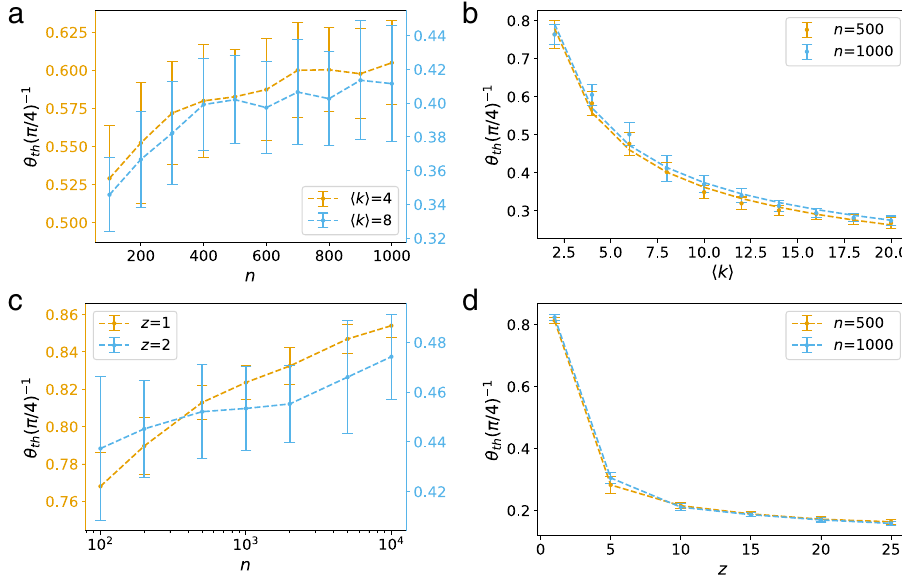
Fig. 10 The Fast ConPT calculation on complex networks. a The behavior of θ th for ER networks with k h i ¼ 4 and k h i ¼ 8 under the S 1 approximation with increasing network size. b The behavior of θ th for Erd ő s--Rényi (ER) networks with n = 500 and n = 1000 as a function of k h i for the S 1 approximation. The circles are the simulated values of the percolation threshold and the dotted lines are a power-law fi t with θ th / k h i (cid:2) 0 : 5 . c The behavior of θ th on Barabási--Albert (BA) networks with z = 1 and z = 2 under the S 1 approximation with increasing network size. d The behavior of θ th for BA networks with n = 500 and n = 1000 as a function z under the S 1 approximation. All results are averaged over 100 network realizations and the error bars represent one standard